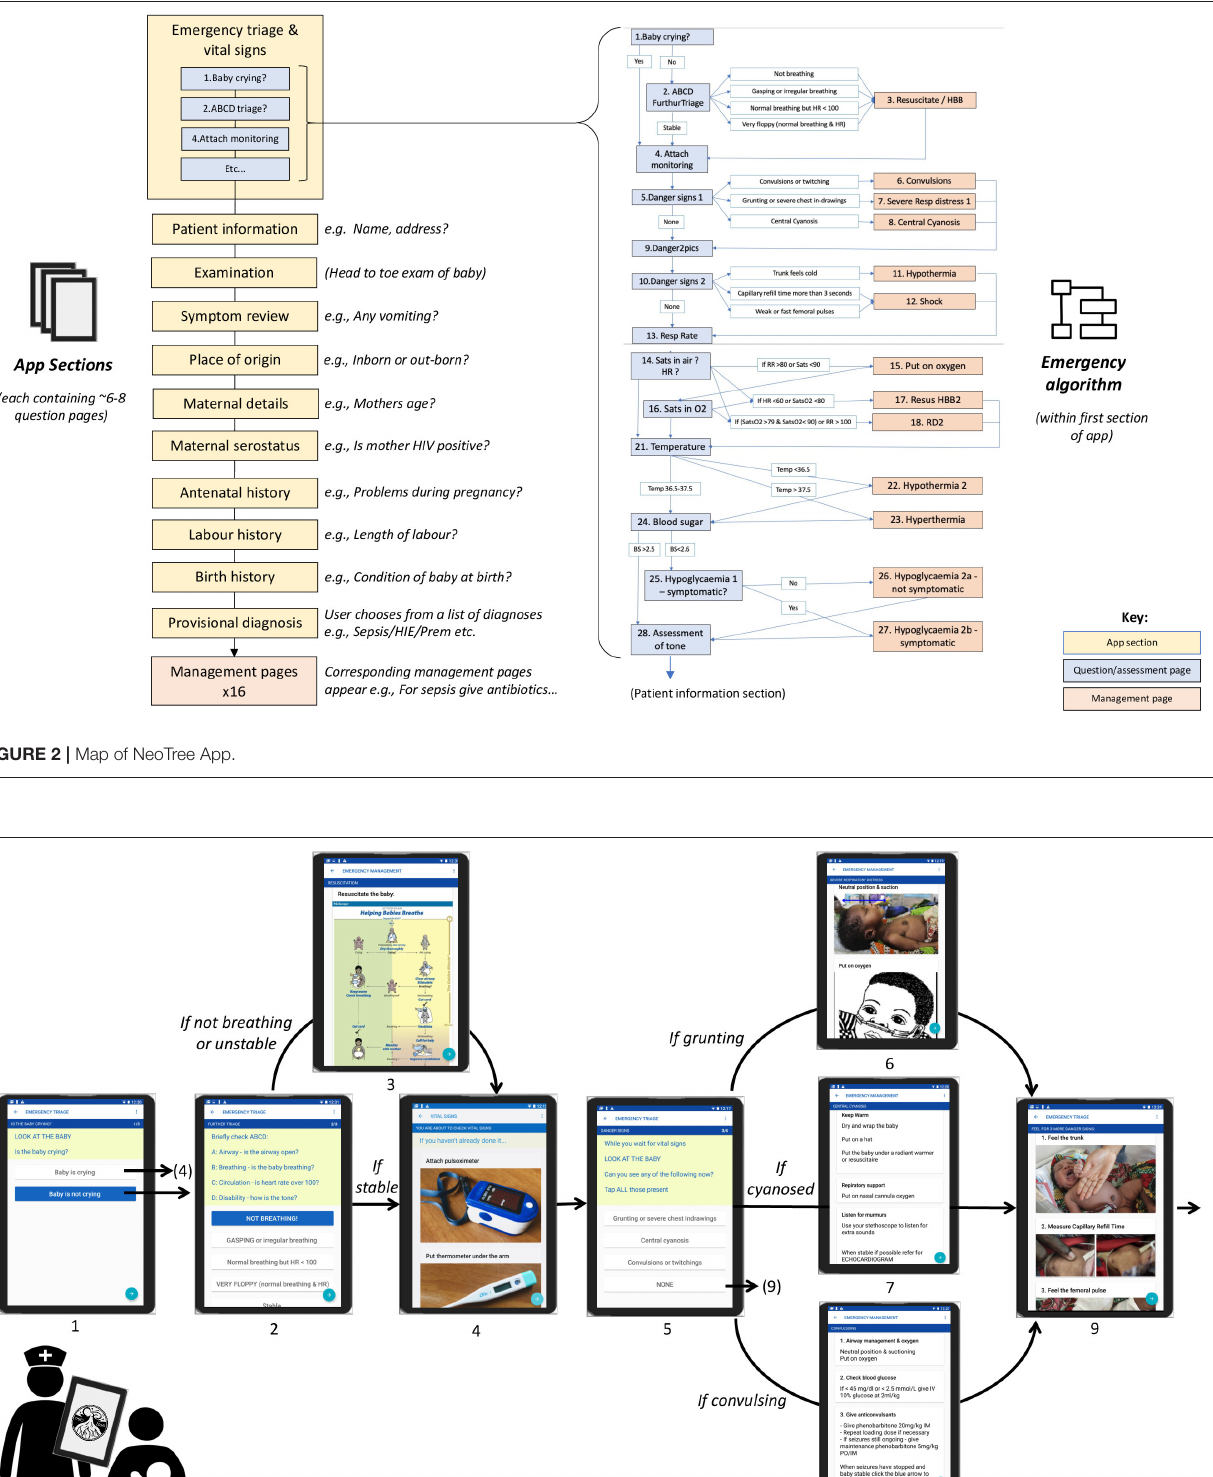
Frontiers in Public Health |